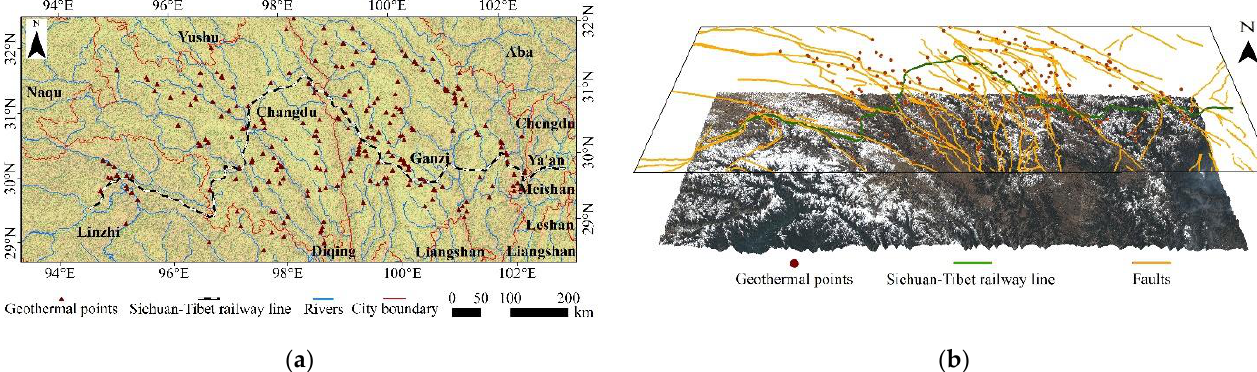
Figure 2. Geographical location and topography of the study area. ( a ) Location of the study area; ( b ) topography of the study area (Landsat8 true color synthetic overlaid DEM; spatial resolution: 30 m; acquisition time: 2018.11 – 2019.1).